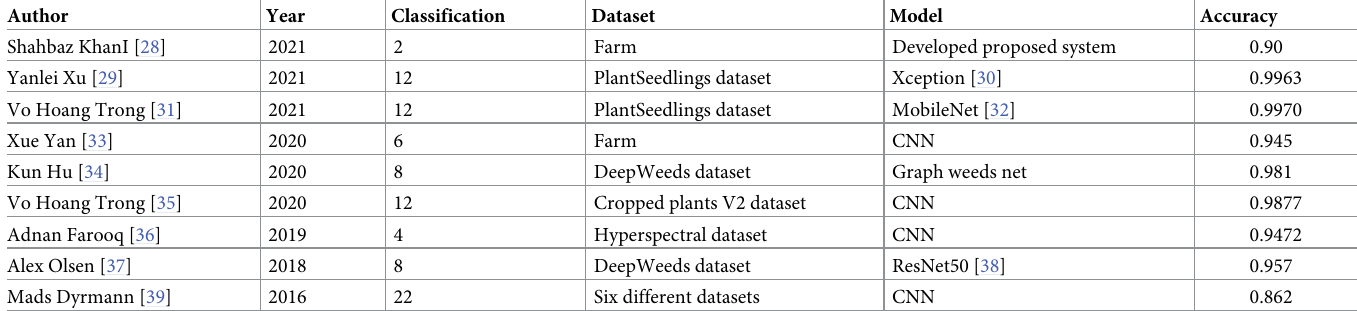
Table 1. Convolutional neural network